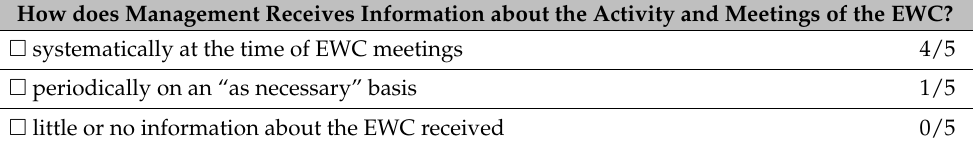
Table 12. Management information on the activities and meeting of the